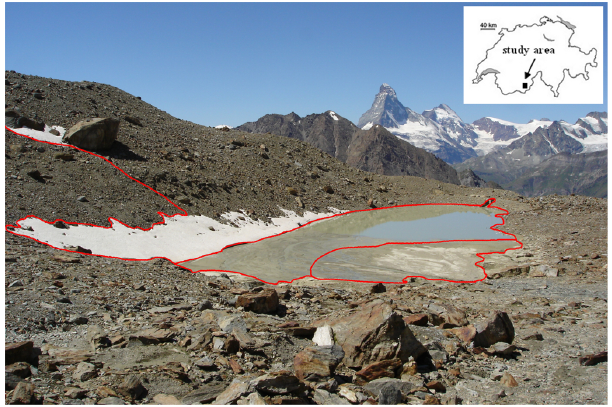
Fig. 1. Photograph of the Weingarten glacier lake on a field visit on 29 July 2009 with GPS path in red. The figure inset shows the location of the lake in